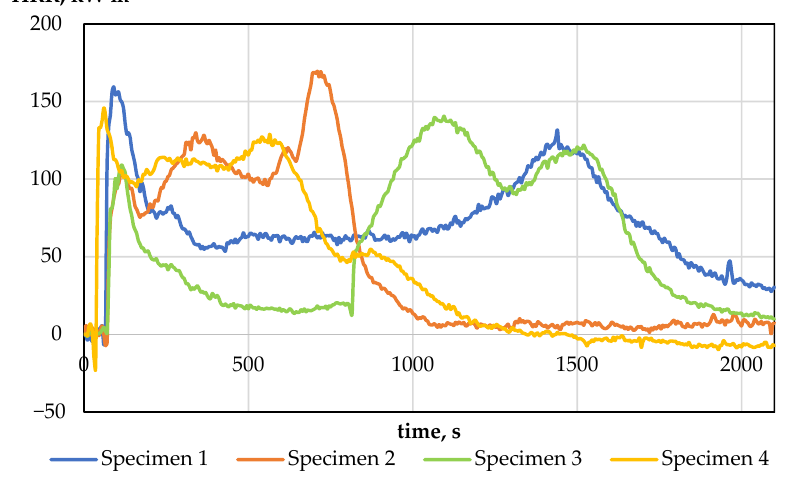
Figure 15. HRR as a function of time for tested cables on cone calorimeter.